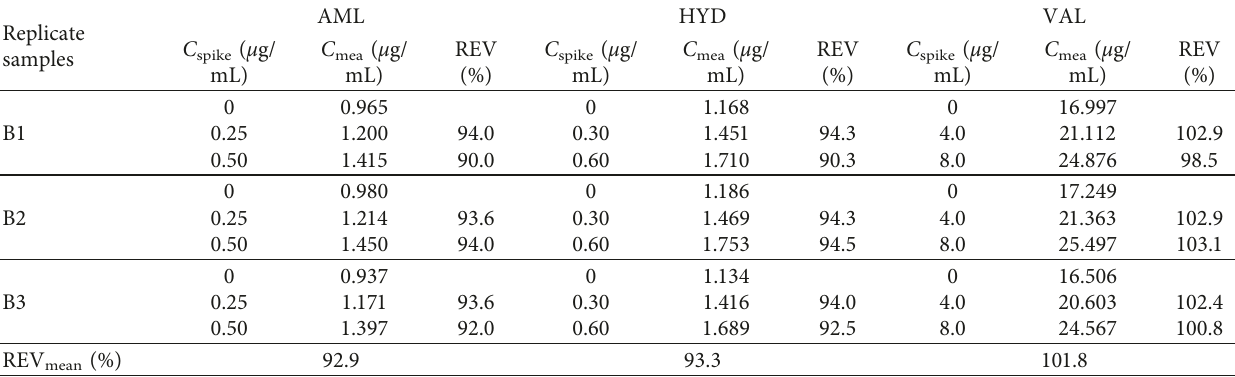
Table 8: Method recovery for Exforge HCT tablet samples.